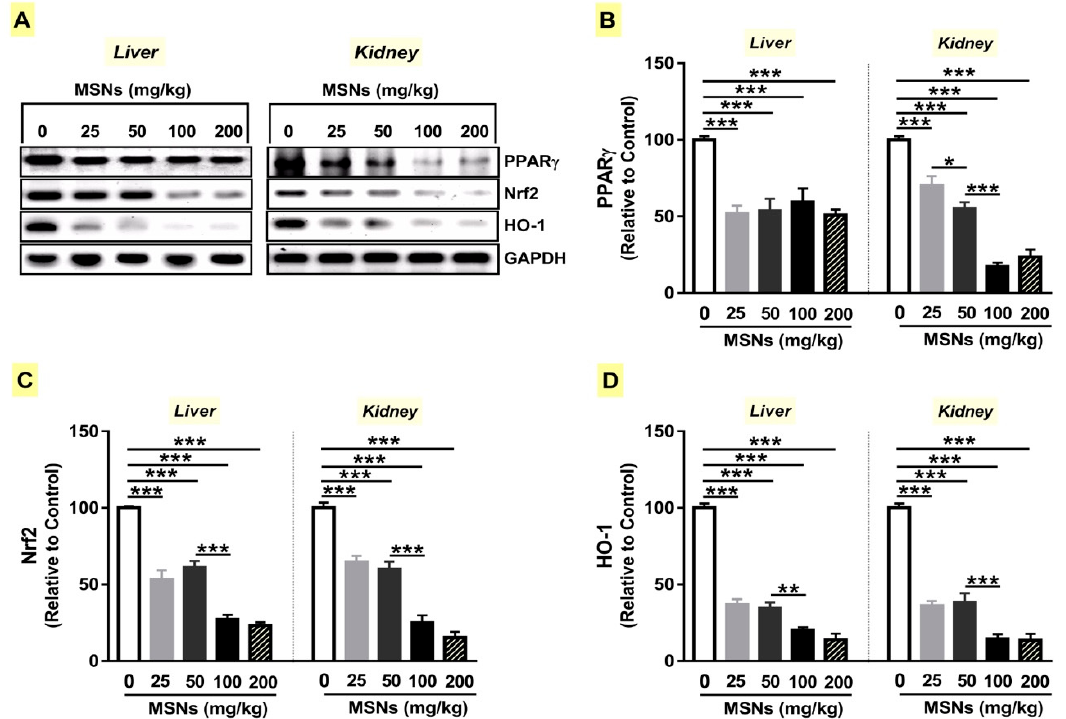
Figure 4. MSNs suppress peroxisome proliferator activated receptor gamma (PPAR γ ) expression and nuclear factor erythroid 2-related factor 2 (Nrf2) / heme oxygenase 1 (HO-1) signaling in the liver and kidney of rats. ( A ) Representative blots of PPAR γ , Nrf2, and HO-1. ( B – D ) The expression of PPAR γ ( B ), Nrf2 ( C ), and HO-1 ( D ) was significantly decreased in the liver and kidney of MSNs-induced rats. Data are mean ± SEM ( n = 6). * p < 0.05, ** p < 0.01, and *** p < 0.001.